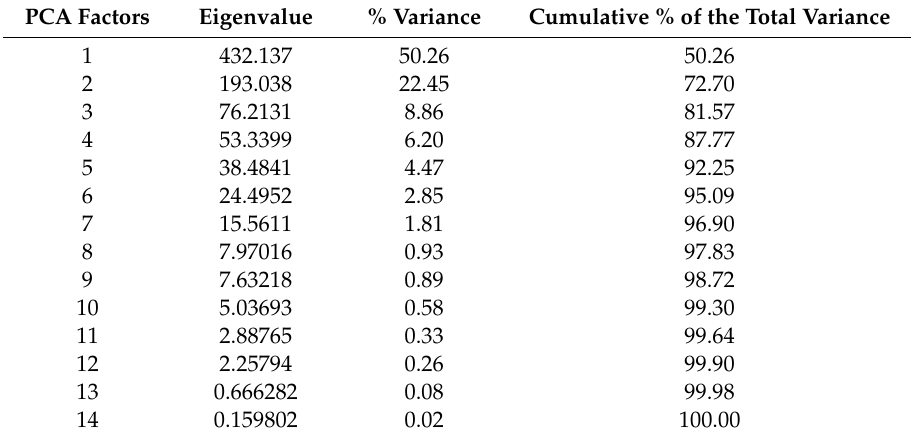
Table 2. Principle component analysis (PCA) factors based on planktonic foraminifera and their percentages of the total variability for core KIM-2A.